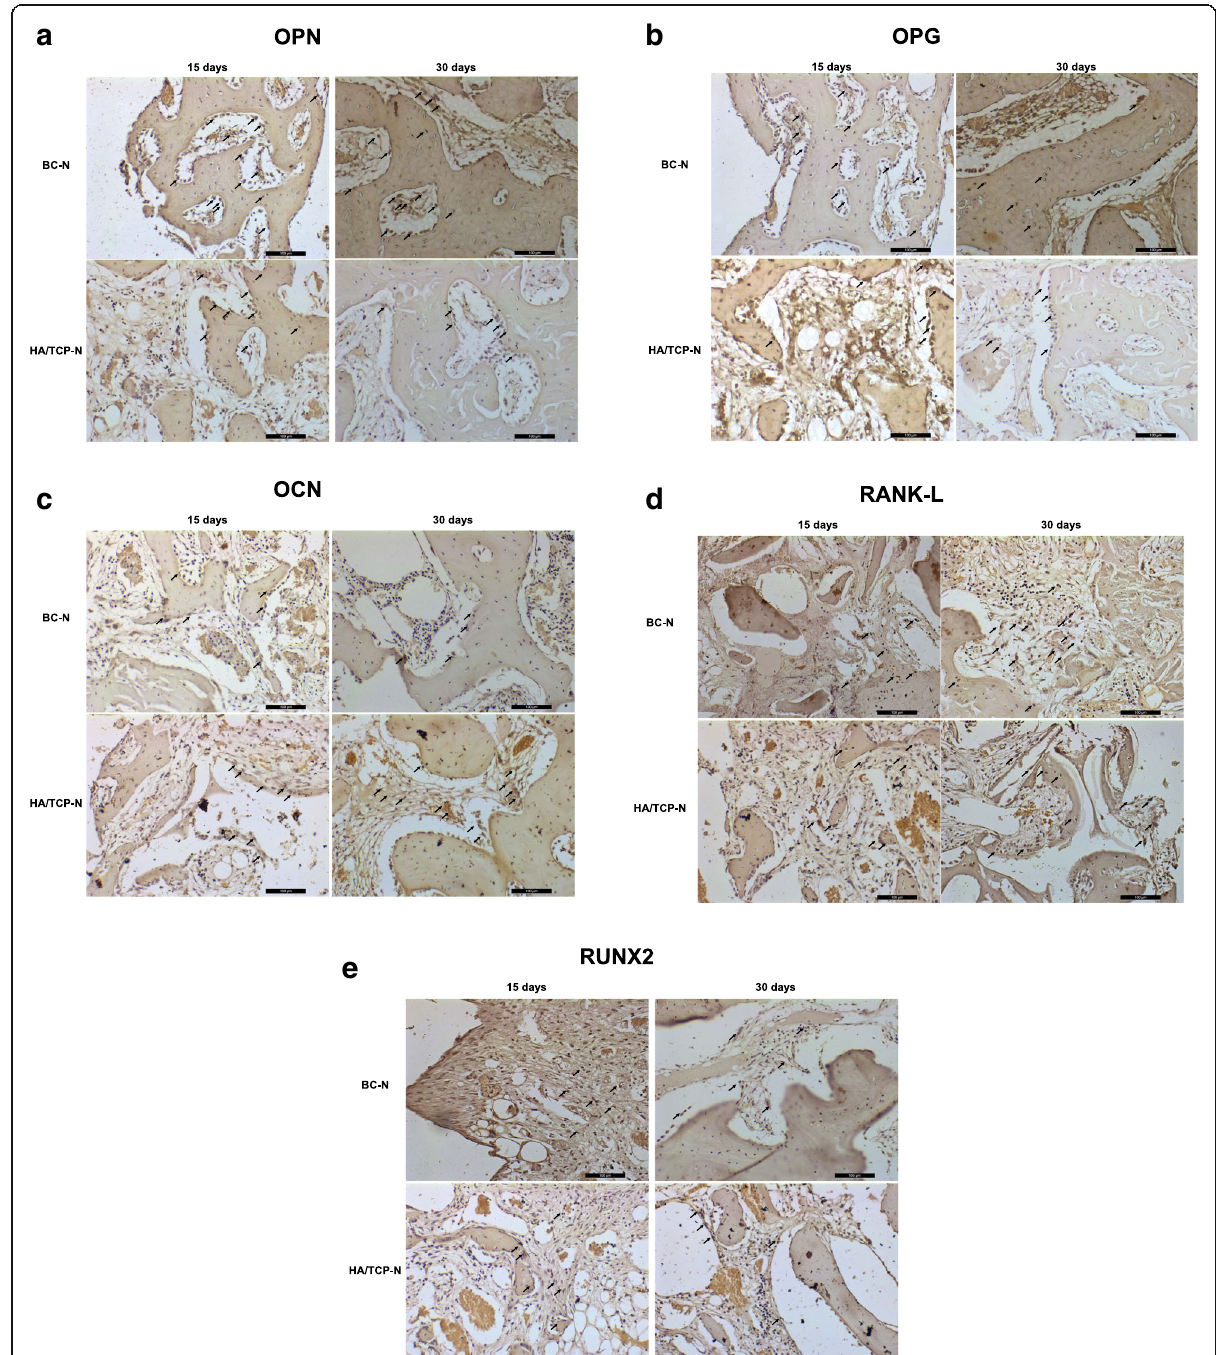
Fig. 8 Labeled samples for all antibodies according to porous surfaces groups at both periods ( a – e ). Immunolabeling of proteins (black